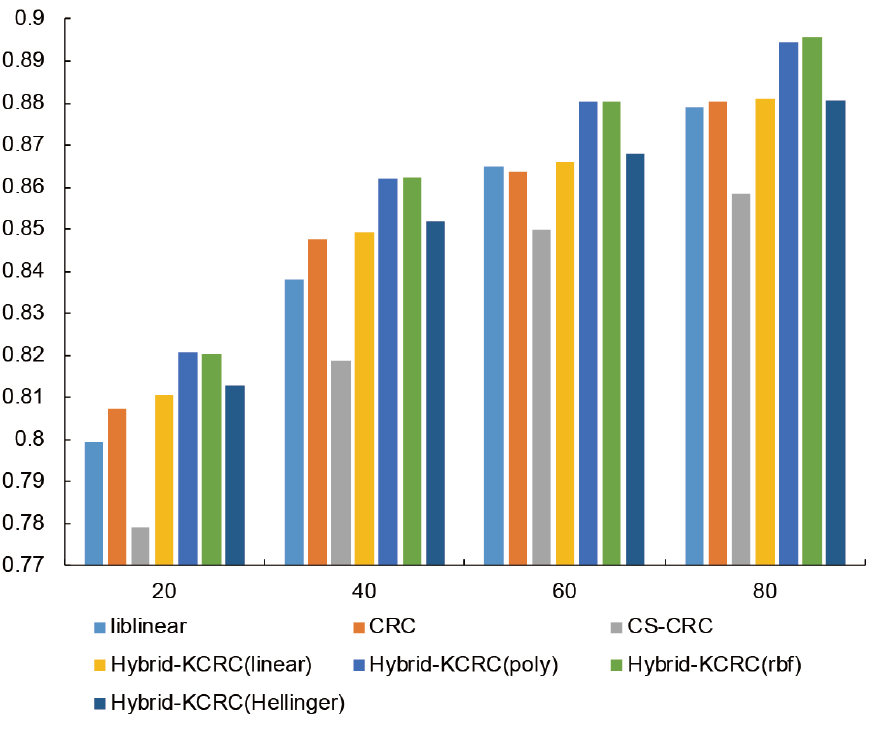
Figure 12. Classification rate on the AID dataset with a different number of training samples in each